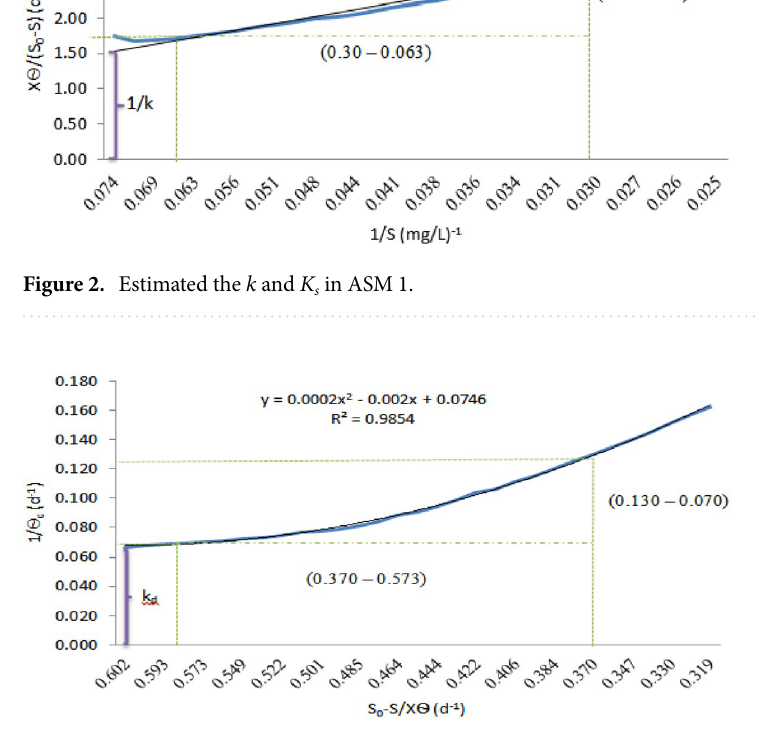
Figure 3. Estimated the k d , Y and, µmax in ASM 1.